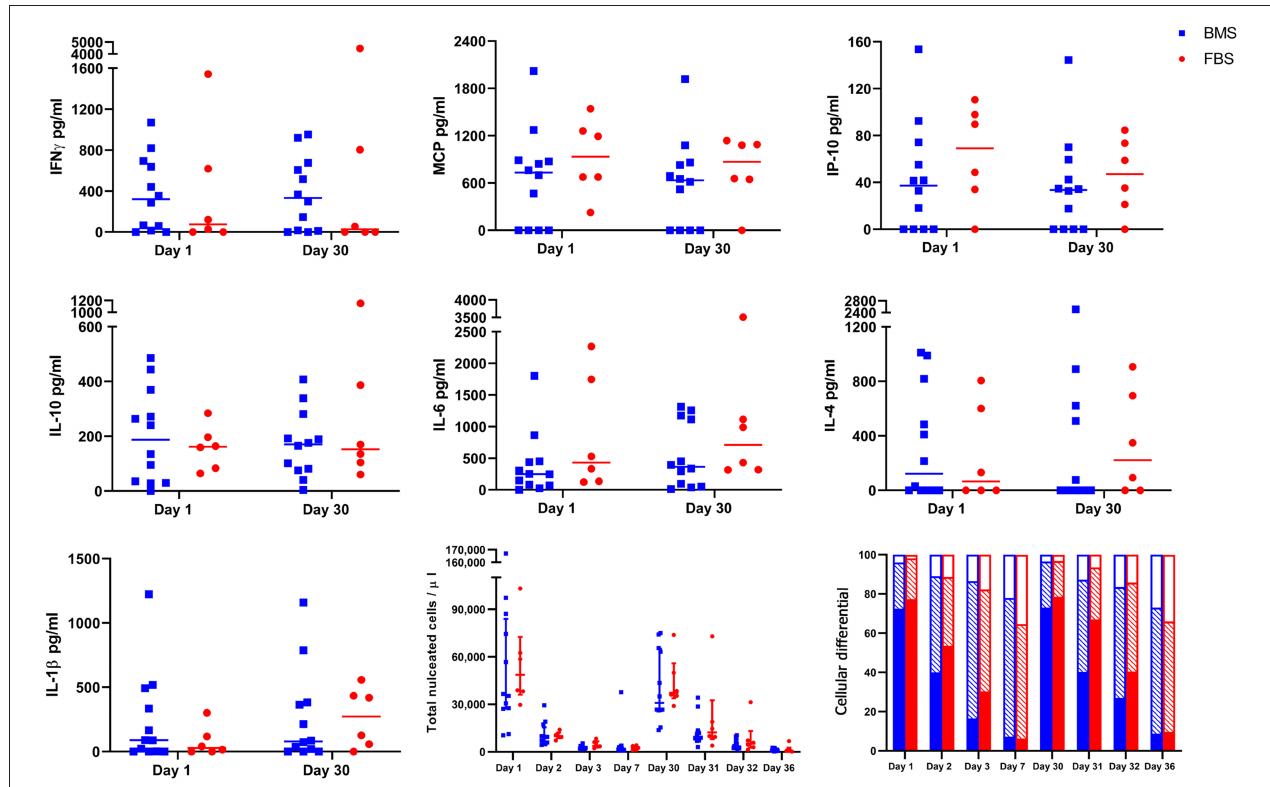
FIGURE 4 | No differences in cytokine and chemokine concentration, total nucleated cell count, or cellular differential after either injection on days 0 and 29. There were no differences in concentration of IFN γ , MCP, IP-10, IL-10, IL-6, IL-4, IL-1 β in synovial fluid on days 1 or 30 between groups. Likewise, there were no differences